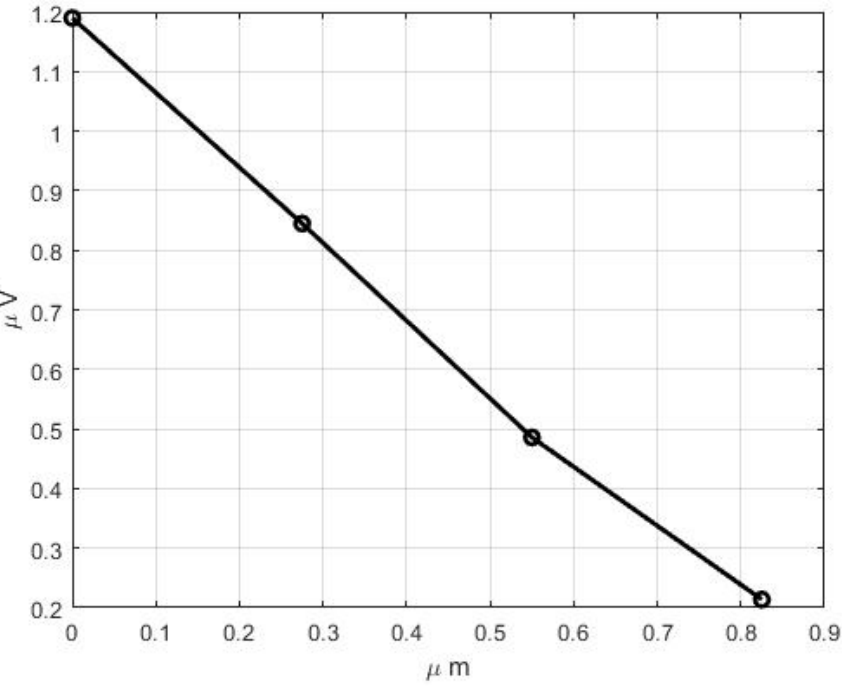
Figure 8. Distribution of electric potential of the individual microtubules at their bases.